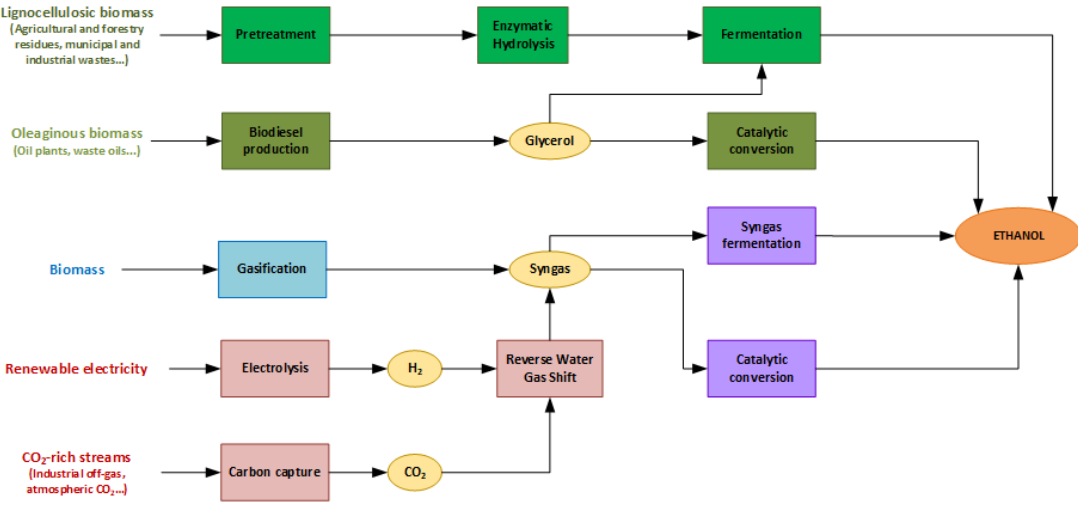
Figure 3. Different bioethanol production pathways (adapted from [55]). Figure 3. Di ff erent bioethanol production pathways (adapted from